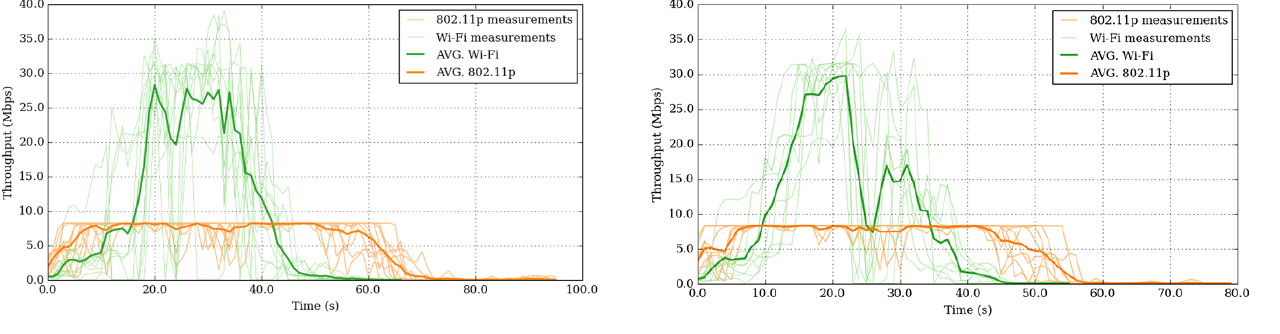
Figure 10. Data throughput from combined RWS–RSU to vehicle with 100kmh − 1